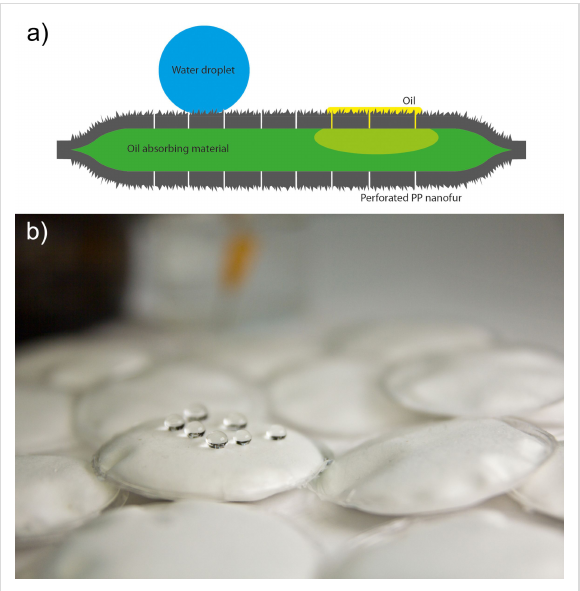
Figure 7: (a) Schematic side view of the nanopads indicating their functionality. Two perforated polypropylene foils, which are covered with nanofur on the outside, enclose an oil-absorbing material. The two foils are heat-sealed at the edge. If the nanopads are dipped in an oil spill, the oil is adsorbed by the nanofur, penetrates into the small holes, and is finally absorbed by the enclosed oil-absorbing material. The small holes are mechanically punched into the nanofur film and have diameters of about 100 µm. (b) Photo of several nanopads (diam- eter: 48 mm) produced as described in the text. Due to the nanofur cover, the pads are strongly water repellent as demonstrated by the water droplets positioned on the nanopad in the middle of the photo.